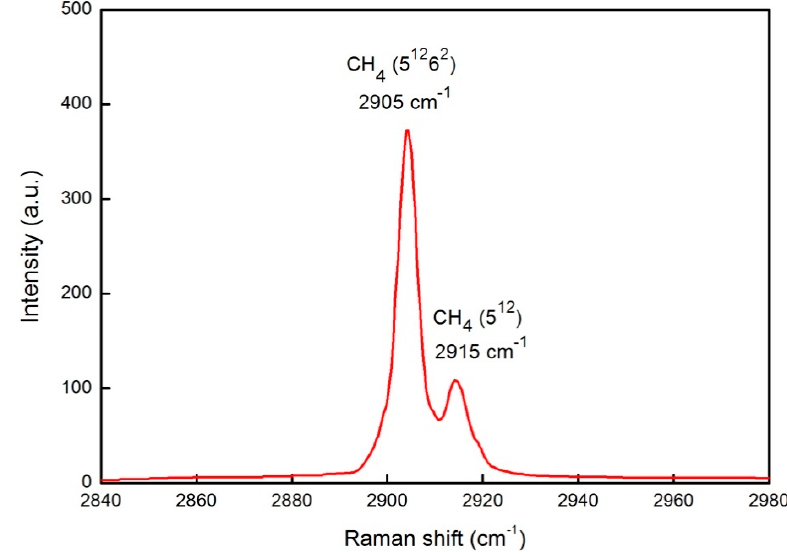
Figure 2. Raman spectra for the C–H stretching mode of the CH 4 molecules enclathrated into the large 5 12 6 2 (2905 cm − 1 ) and small 5 12 (2915 cm − 1 ) cavities of the structure I hydrate. The spectral resolution achieves 0.6 cm − 1 as described in Section 2.1.